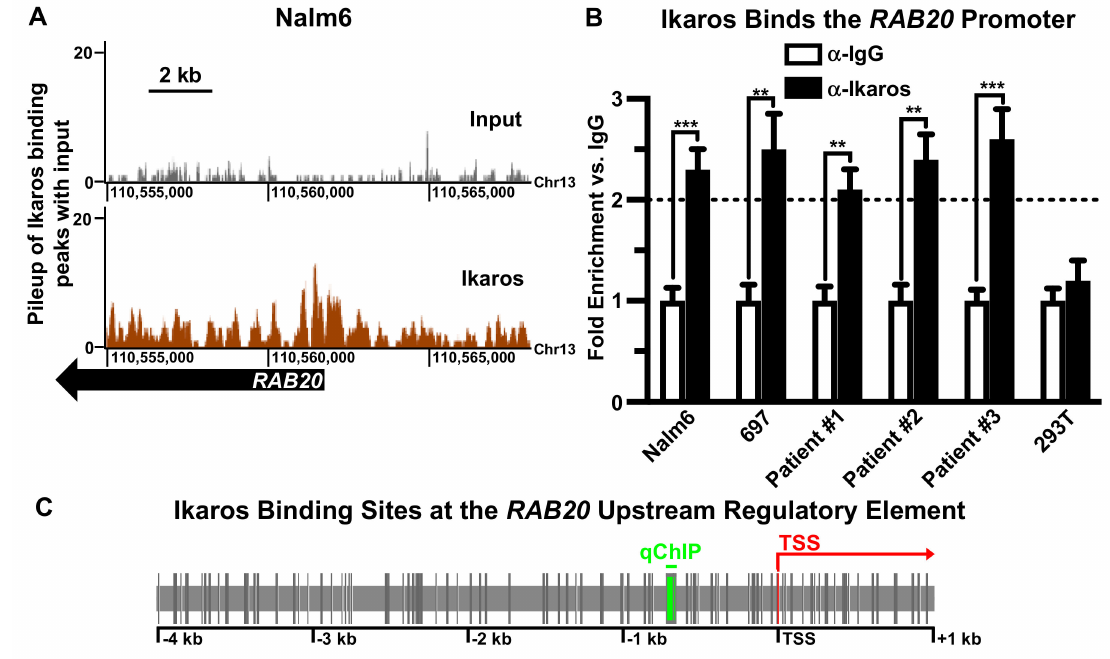
Figure 1. Ikaros binding in the RAB20 URE. ( A ) ChIP-seq signal map for Ikaros binding to the RAB20 promoter in the Nalm6 B-ALL cell line. ( B ) qChIP analysis of Ikaros occupancy at the RAB20 promoter in human B-ALL cell lines, primary human B-ALL cells, and Ikaros-null HEK293T cells. The graphed data is the mean ± SD (error bars) from three independent experiments. ( C ) Schematic diagram of Ikaros consensus binding motifs (–GGGA– and –GGAA–) in the human RAB20 upstream regulatory element (grey vertical lines). The green line marks the site that was analyzed by qChIP and the TSS is marked by the red